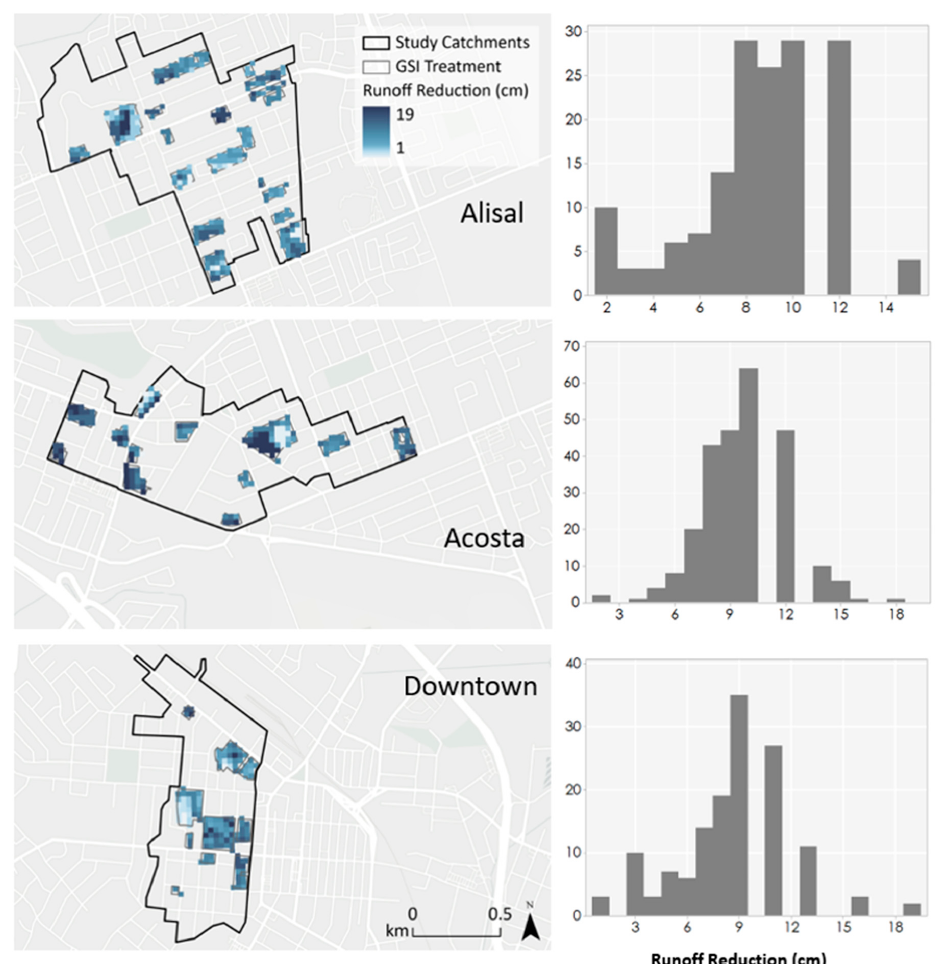
Figure 8. Estimated long-term annual runoff reductions from swTELR for potential Green Stormwater Infrastructure (GSI)implementation sites in Salinas. Histograms show grid cell counts in each study catchment.